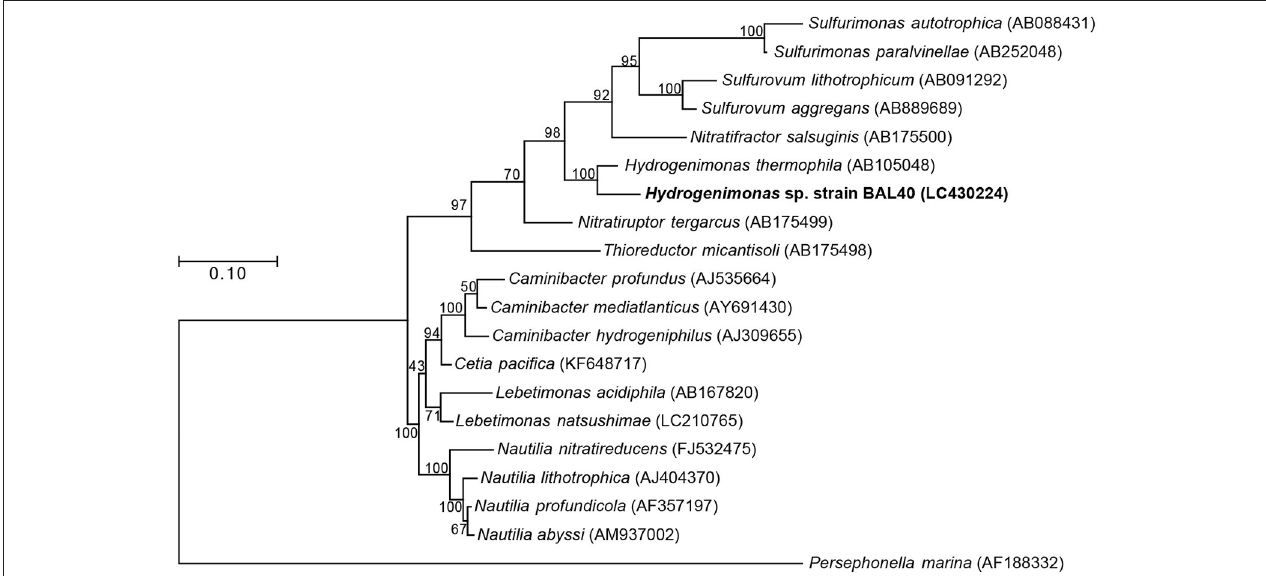
FIGURE 2 | ML Phylogenetic tree based on 1,196 nucleotide position of 16S rRNA gene sequences. Bootstrap values based on 500 resampling replicates are shown as percentages at branch nodes.